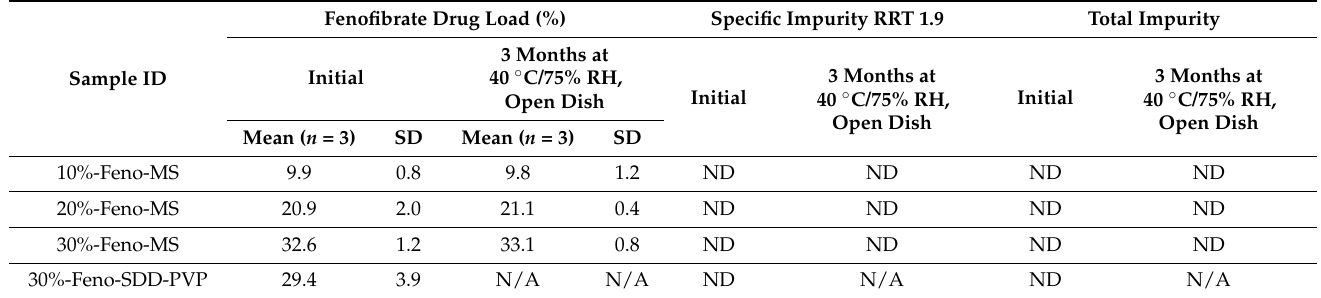
Table 2. Assay and chemical impurity of the Feno-loaded MS or SDD samples at the initial and 3M accelerated open dish stage of 40 ◦ C/75%